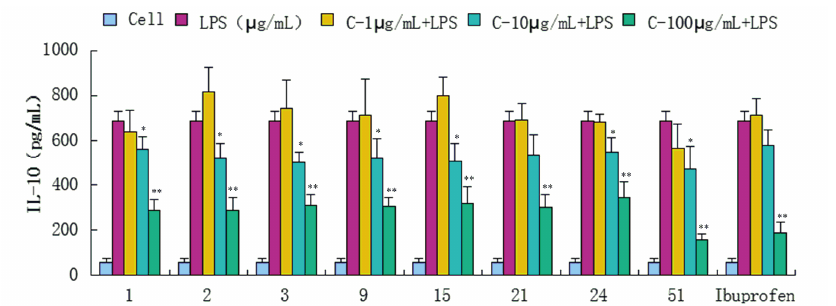
Figure 8. Inhibitory effects of compounds 1 , 2 , 3 , 9 , 15 , 21 , 24 and 51 (1, 10, 100 μ g/mL) on IL-10 production stimulated by LPS (10 μ g/mL) in RAW 264.7 cells (mouse leukemic monocyte macrophage cell line). Data are expressed as mean ± S.E.M. of three independent experiments. Cell: cultures were not exposed to lipopolysaccharide (LPS); LPS: cultures were subjected to LPS; LPS + Drug: Compounds were added to the cultures during LPS; Positive control: LPS + Ibuprofen. * p < 0.05 vs. LPS; ** p < 0.01 vs.